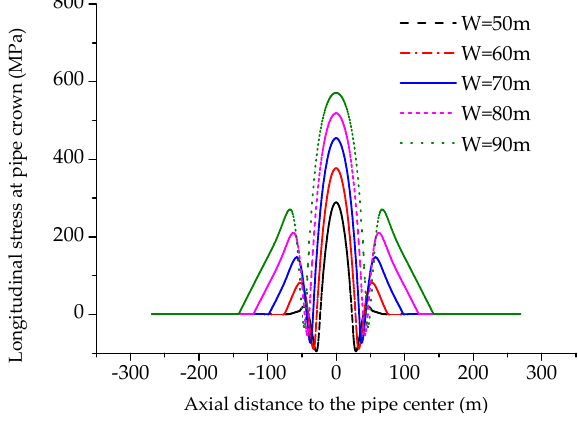
Figure 21. Longitudinal stresses at pipe crown for pipes with various wall thicknesses.